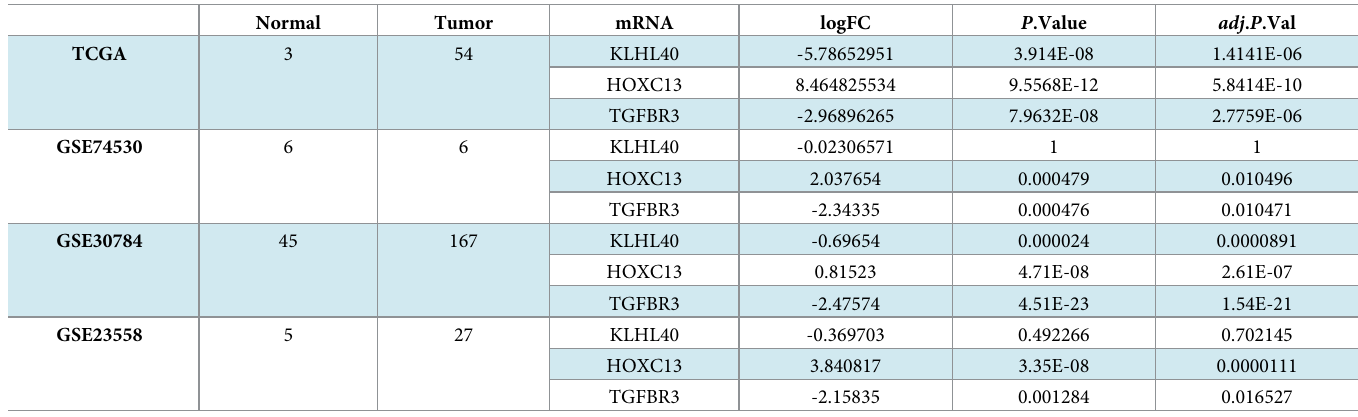
Table 2. The expression trend of the 3 molecules.